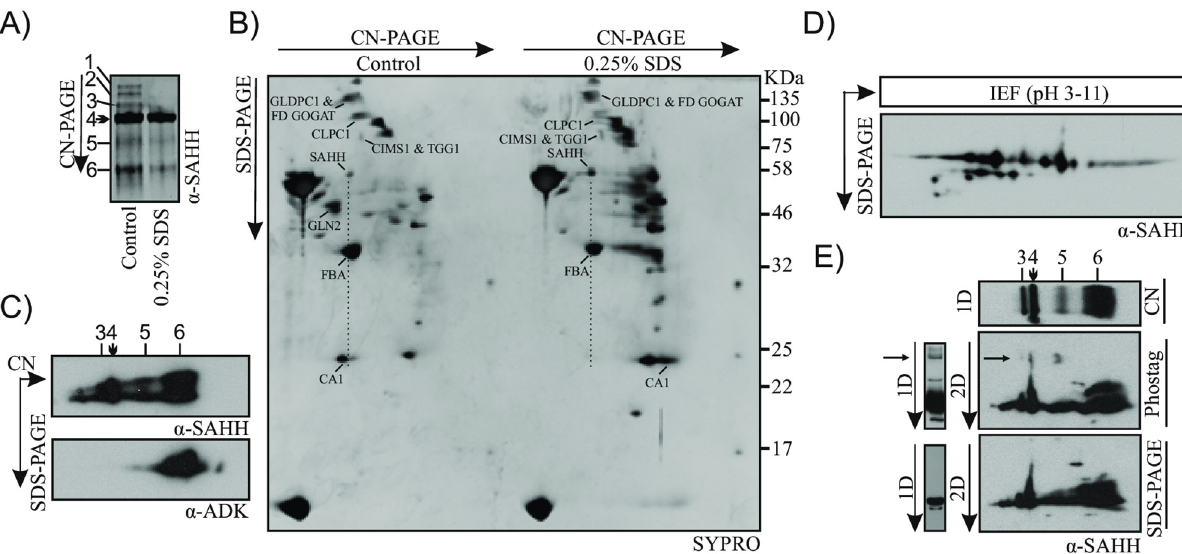
Fig 3. Biochemical analysis of A . thaliana SAHH. A) A . thaliana leaf extracts were incubated in the presence and absence of 0.25% SDS and thereafter separated on Clear Native (CN) gels. SAHH was detected by immunoblotting using anti-SAHH antibody. B) A . thaliana leaf extracts were incubated in the presence and absence of 0.25% SDS and thereafter separated on Clear Native (CN) gels followed by 12% acrylamide SDS-PAGE in the second dimension, which was stained with a total protein stain (SYPRO). The SAHH-containing major spots originating from the SAHH complex 4, as well as CARBONIC ANHYDRASE 1 (CA1), FRUCTOSE BISPHOSPHATE ALDOLASE (FBA), GLYCINE DECARBOXYLASE P-PROTEIN 1 (GLDPC1), FERREDOXIN-DEPENDENT GLUTAMATE SYNTHASE 1 (FD GOGAT), CLPC HOMOLOGUE 1 (CLPC1), COBALAMIN-INDEPENDENT METHIONINE SYNTHASE (CIMS1), THIOGLUCOSIDE GLUCOHYDROLASE 1 (TGG1), and GLUTAMINE SYNTHASE 2 (GLN2) are marked. C) A . thaliana leaf extracts were separated on 2D-CN PAGE and SAHH and ADK were detected by immunoblotting using anti-SAHH and anti-ADK antibodies. SAHH complex 4, which does not co-migrate with ADK, is marked with an arrow. D) A . thaliana leaf extracts corresponding to 100 μ g of protein were fractionated by isoelectric focusing in a pH range from 3 to 11 and subsequently separated by 12% acrylamide SDS-PAGE in the second dimension. E) A . thaliana leaf extracts corresponding to 25 μ g of protein were fractionated on CN-PAGE and the protein complexes were thereafter separated on 7.5% acrylamide Phostag-PAGE or on a similar 7.5% acrylamide SDS-PAGE lacking the Phostag reagent. SAHH complex 4 in the horizontal lane of 1D CN-PAGE is indicated by an arrowhead. SAHH immunoblots of 1D Phostag and 1D SDS-PAGE are shown in parallel to the 2D gels to indicate the SAHH band patterns on the different gel systems. The presence of a slow-migrating SAHH species on the Phostag gel is indicated by